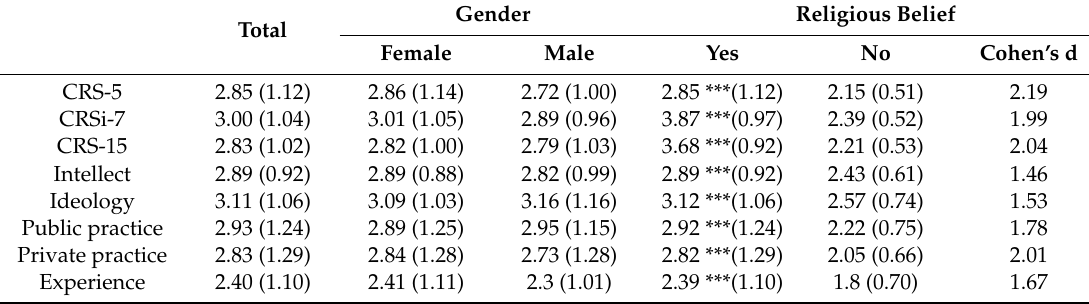
Table A3. Descriptive statistic of CRS-5, CRSi-7, and CRS-15.